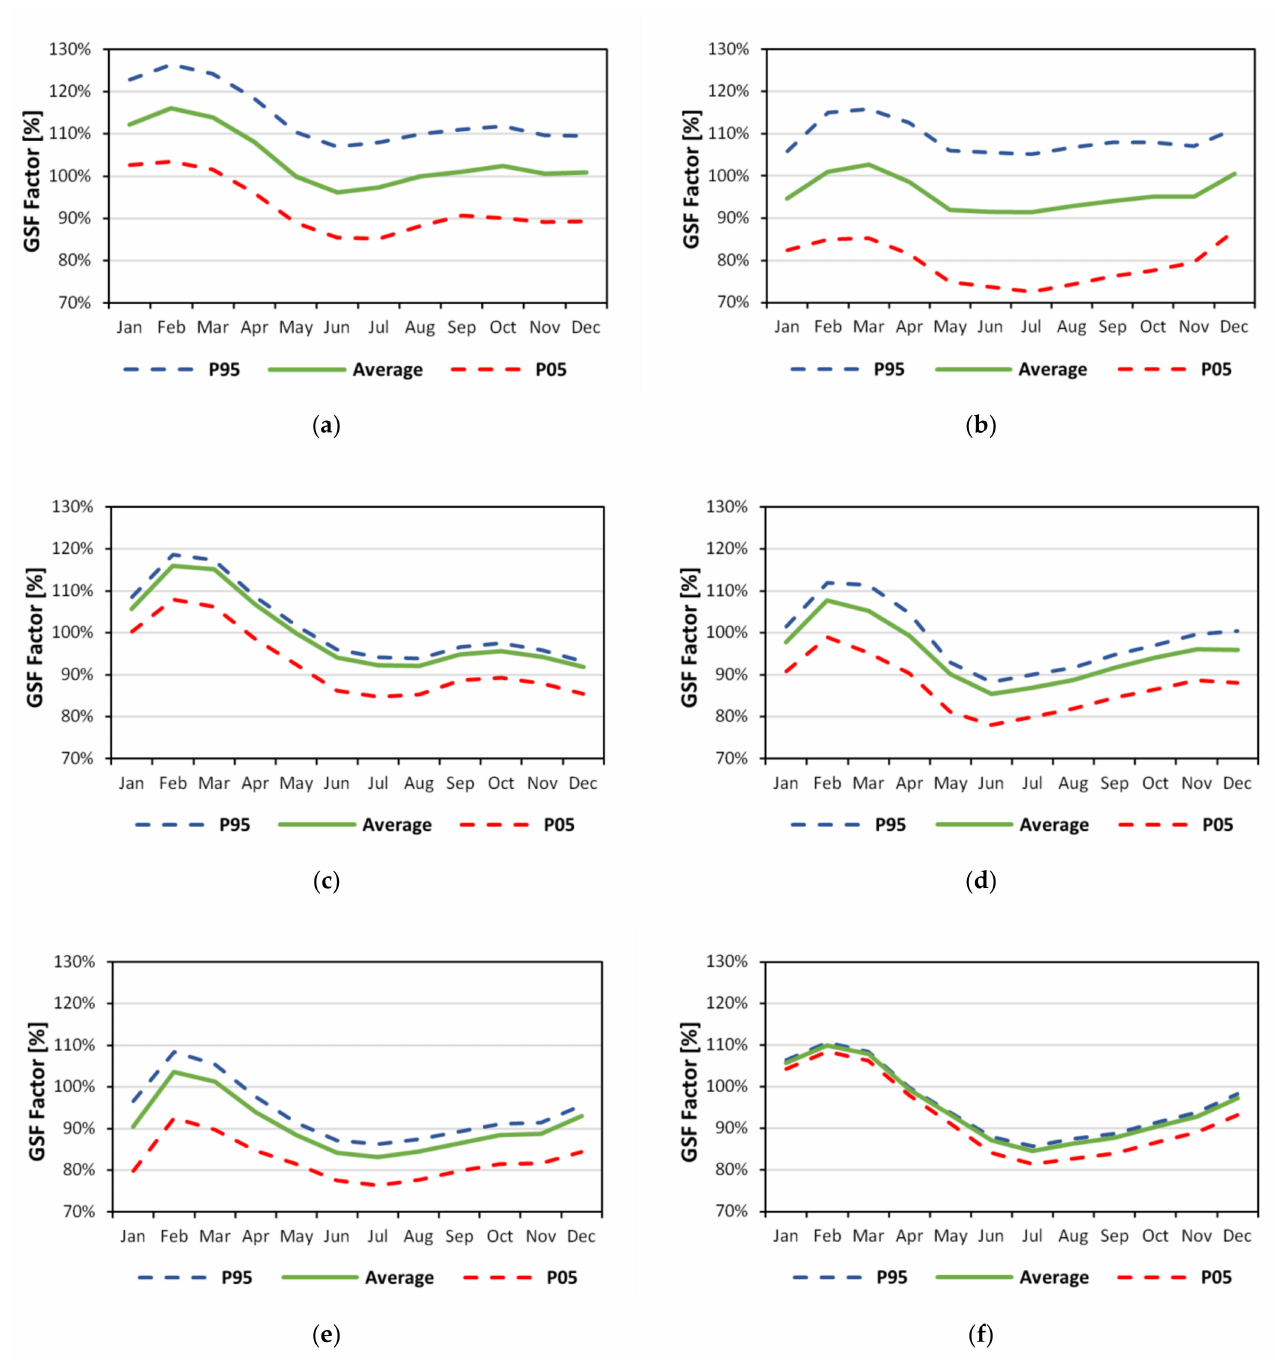
Figure 4. NEWAVE GSF forecasts for the years: ( a ) 2014; ( b ) 2015; ( c ) 2016; ( d ) 2017; ( e ) 2018; and ( f ) 2019. Figure 5 shows the average spot price and GSF factor forecasts for 2019, considering the NEWAVE historical